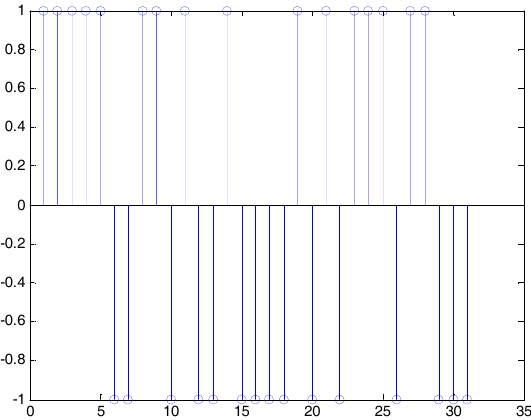
Figure 2. The true pseudo-random (PN) sequence of the direct sequence spread spectrum (DSSS) signal.